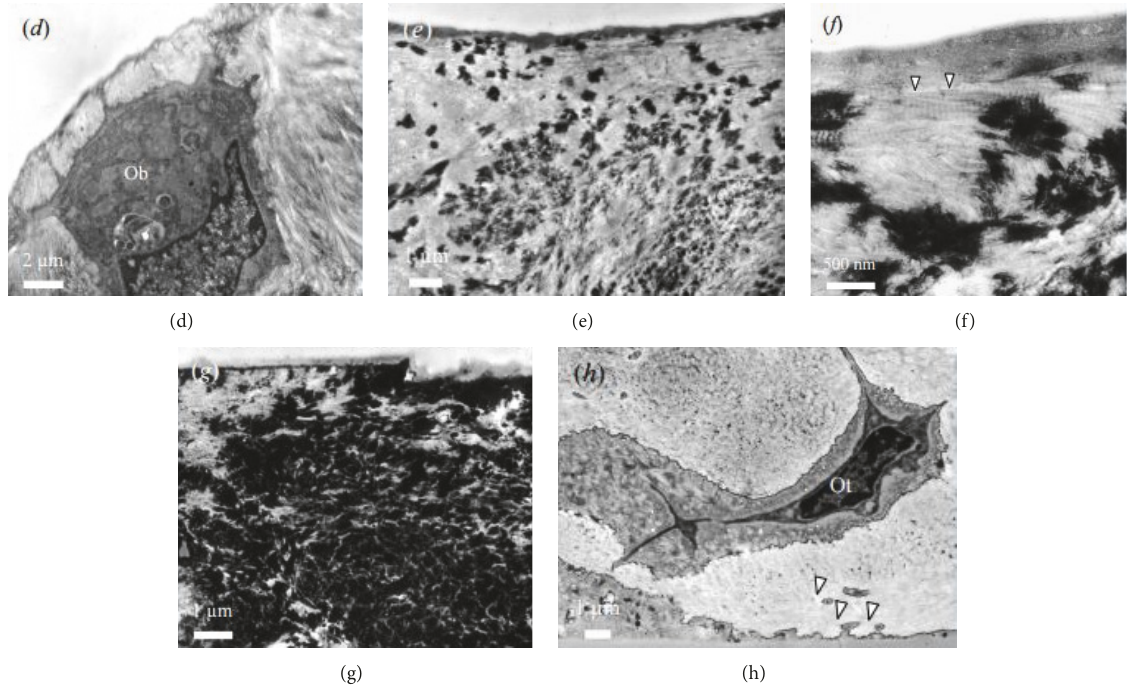
Figure 5: Transmission electron microscopy. The various stages of bone formation adjacent to the Ep surface could be observed at 12 weeks of healing. (a–c) At the bone-implant interface, osteoblasts (Ob) produce an unmineralised extracellular matrix, the osteoid, which undergoes progressive mineralisation. (d) Collagen fibrils are aligned parallel to the osteoblast surface. (e) Early mineralisation stage with patchy distribution of bone apatite (dark areas). (f) In high-resolution, the characteristic 67 nm cross-striated pattern of collagen fibrils (white arrows) can be observed, with accumulation of intra- and interfibrillar mineral. (g) Late mineralisation stage with diffuse distribution of bone apatite (dark areas). (h) An osteocyte (Ot) embedded within the mineralised matrix lies in close proximity to the implant surface with several dendritic processes residing within canaliculi (white arrows), sectioned longitudinally as well as transversally, extending towards the implant